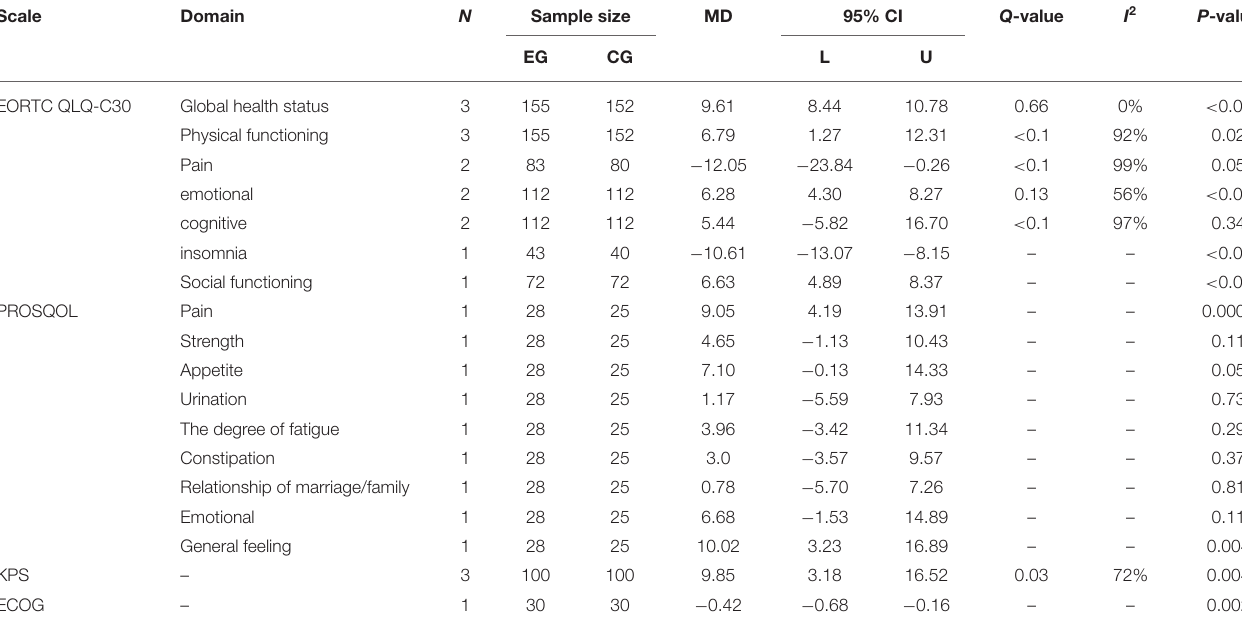
TABLE 4 | Details of scales of quality of life.